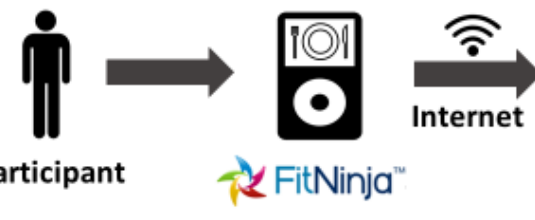
Figure 1. Secure data collection